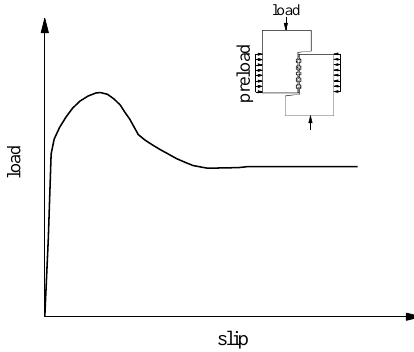
Figure 13. Load–slip curve (data from Rizkalla et al. Figure 13. Load – slip curve (data from Rizkalla et al. [48]).